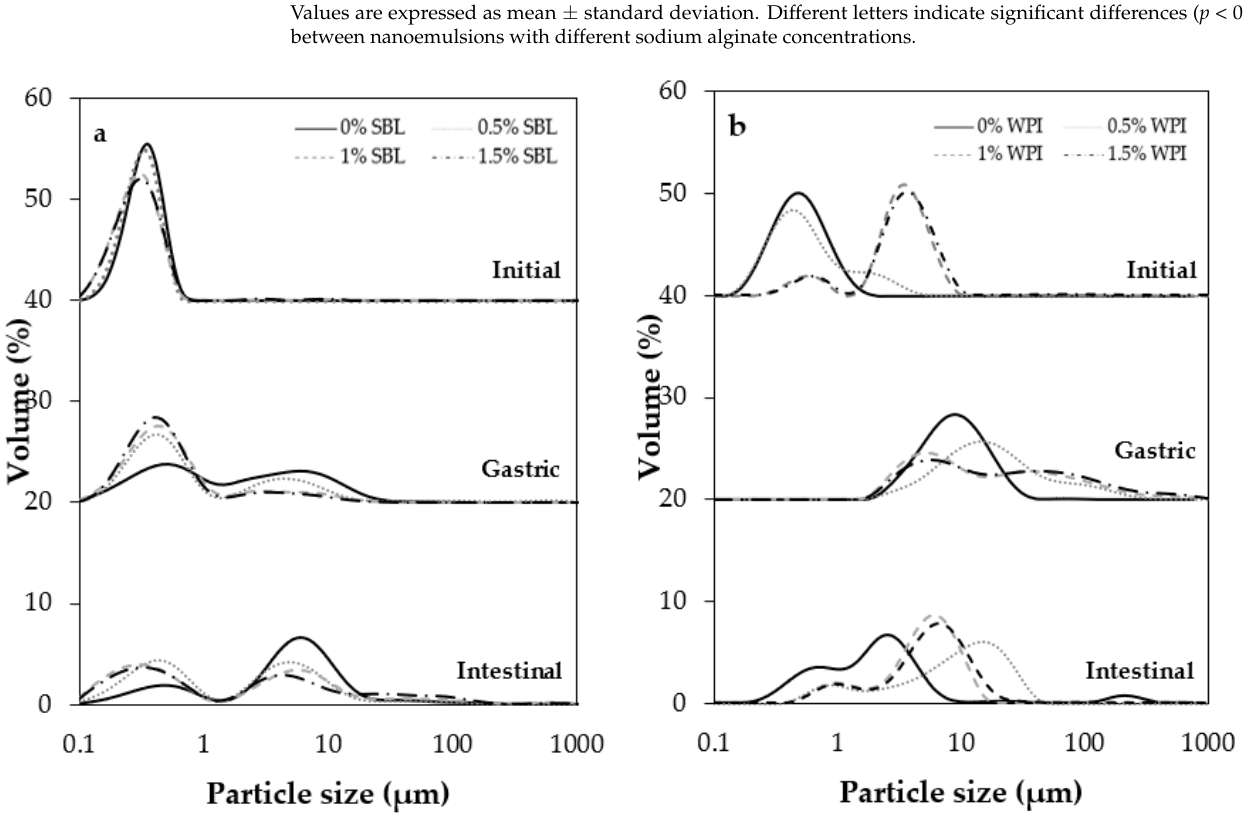
Figure 1. Particle size distribution of curcumin-loaded nanoemulsions stabilized with ( a ) soybean lecithin (SBL) or ( b ) whey protein isolate nanoemulsions (WPI) and different sodium alginate concentrations (0, 0.5, 1, and 1.5%) at different phases of in vitro digestion. The addition of sodium alginate at any concentration significantly increased the par- ticle size of WPI nanoemulsions due to the aggregation of droplets (Figure 2); the most noteworthy changes were observed when using 1% and 1.5% sodium alginate concentra- tions (Table 1). The particle size distribution changed from monomodal to bimodal when the polysaccharide was added to the WPI nanoemulsion, irrespective of the